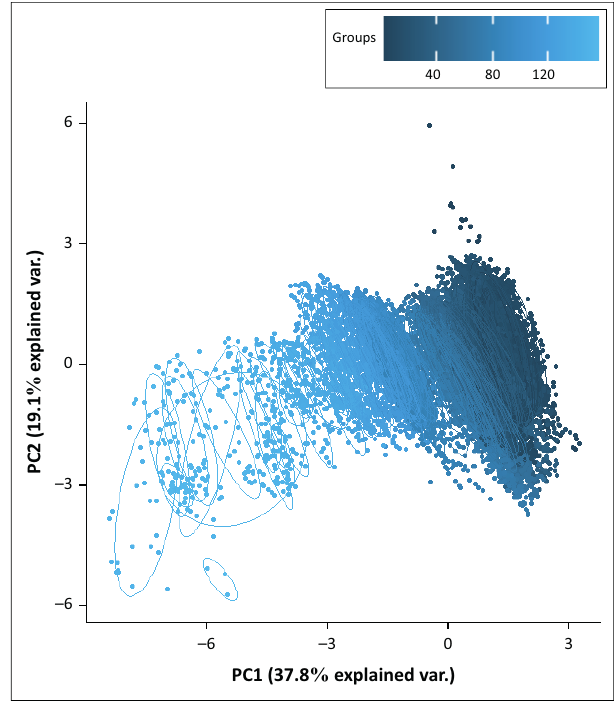
PC1 (37.8 % explained Note: Each dot is an activity rate data point and corresponds with a relevant grouping based on the colour scale. The lower end of the colour scale depicts a high cluster of activity rates centred around the period post-tagging. FIGURE 5: Principal components analysis plot explaining 57.9 % of variance between the activity rates after the tagging procedure and the time of day across the entire data set of all telemetered Hydrocynus vittatus individuals in the present study. The principal components analysis used the activity rates of fish, the time of day (PC1) and the day after the tagging procedure (PC2) to visualise the relationship between these three variables.